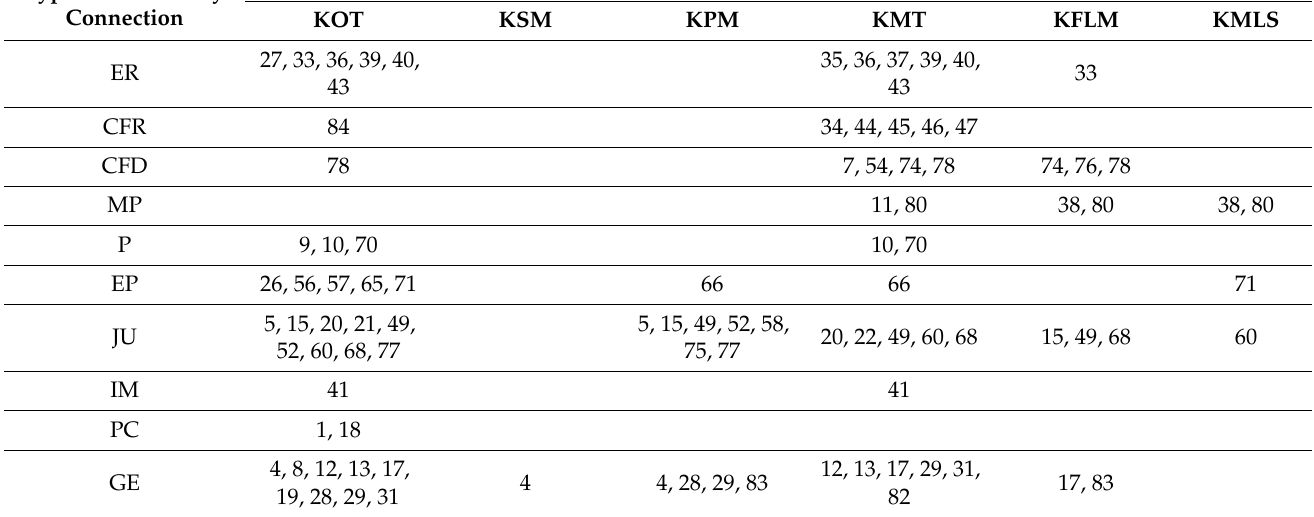
Table 6. Relationship between the establishment of elementary connection and the specialised knowledge mobilised by the teacher in study